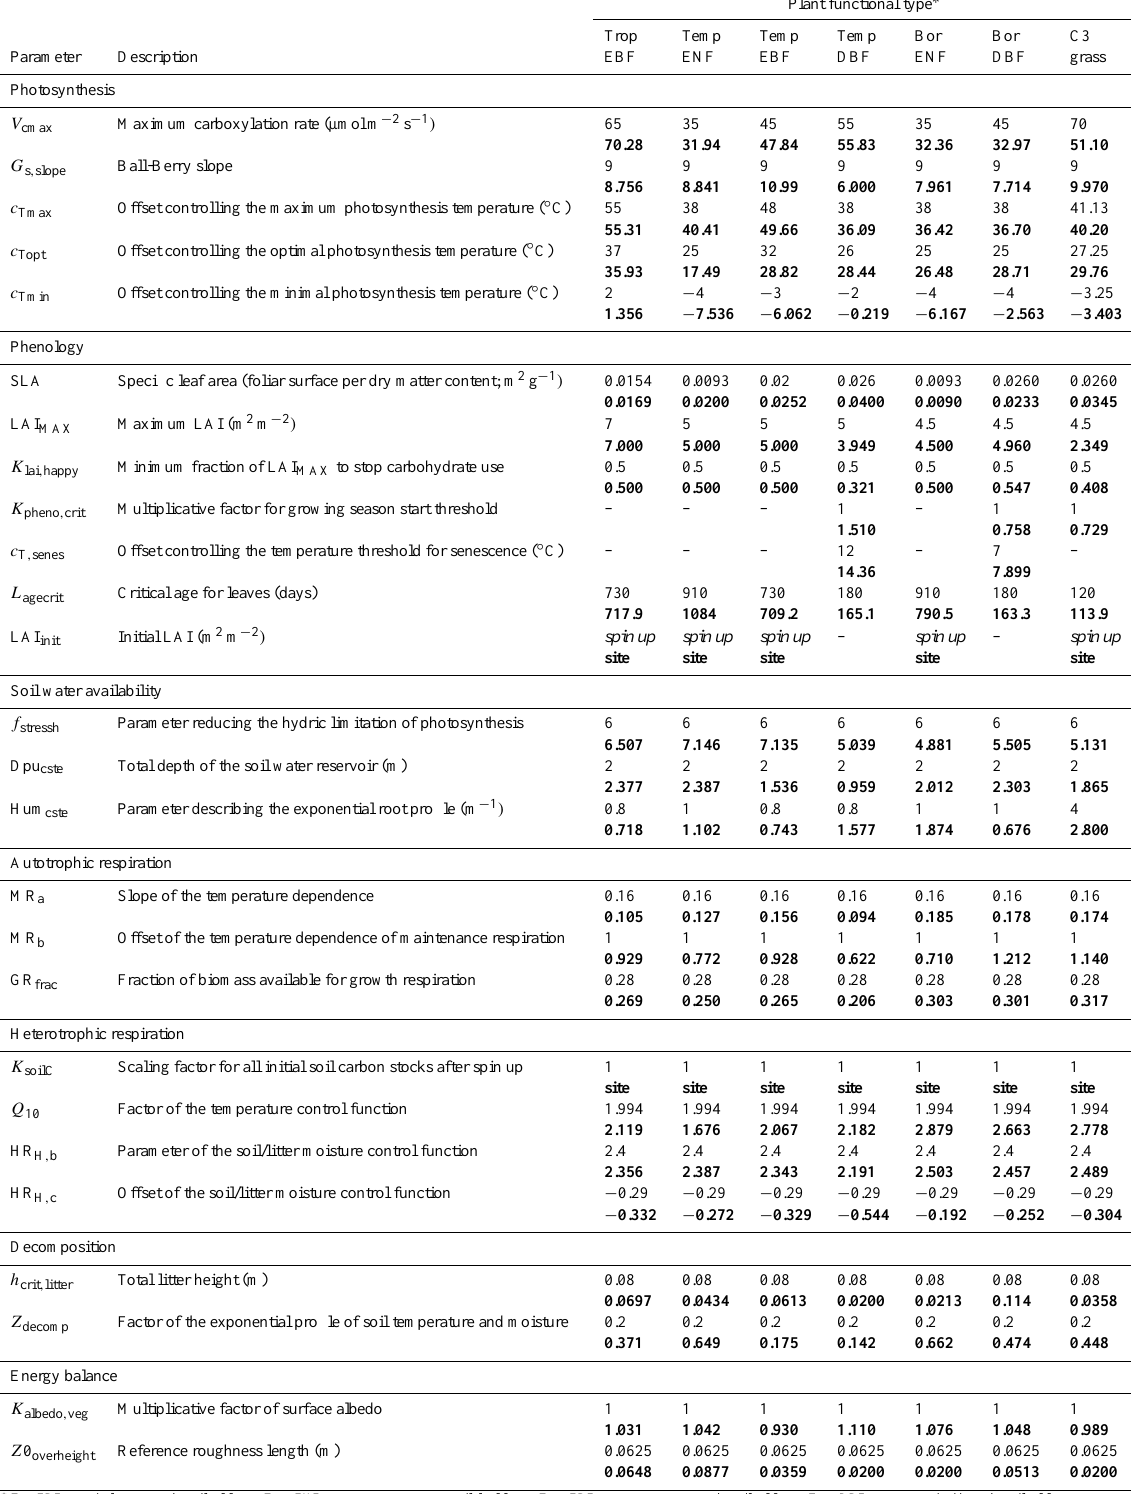
Table 1. Parameters of ORCHIDEE optimized in this study. The prior values are given for each PFT, and the multisite posterior values are in bold font. A hyphen means that the parameter is not optimized, spin up that the spin-up value is taken, and site that the posterior value is